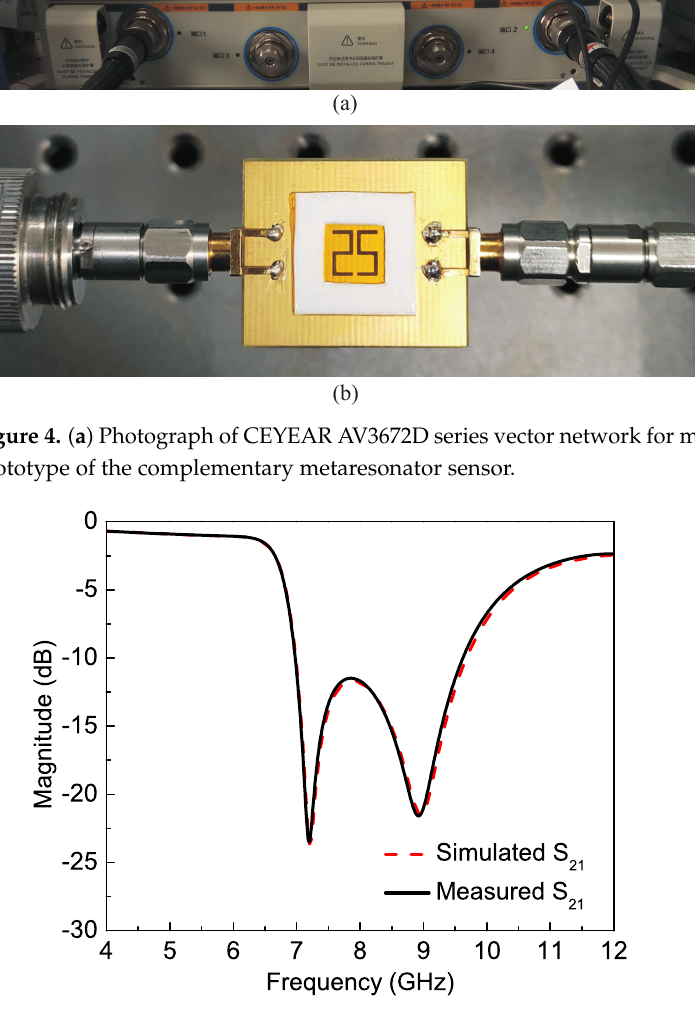
Figure 5. The magnitude of transmission ( S 21 ) coefficient for simulated and measured metaresonator sensor. The unloaded Q factor of the first notch is 55.38 and that of the second notch is